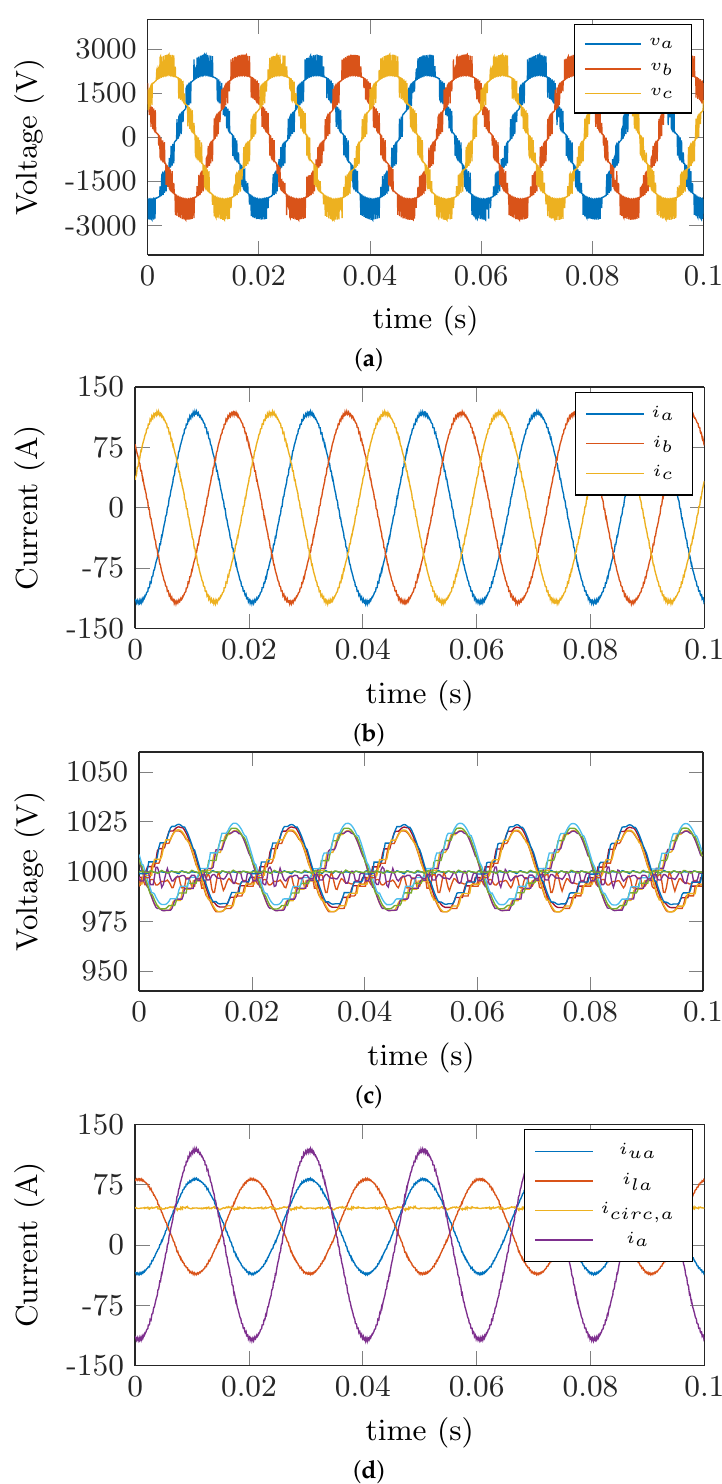
Figure 8. Output waveforms under Mode i : ( a ) three-phase load voltages; ( b ) three-phase load currents; ( c ) SM capacitor voltages of Phase A; ( d ) load, circulating and arm currents of Phase